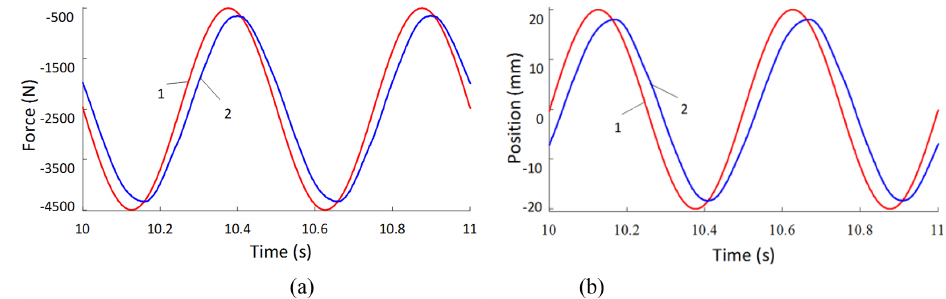
Figure 19. Real-time response curves of 2.0Hz. Real-time change curves of (a) driving force and (b)